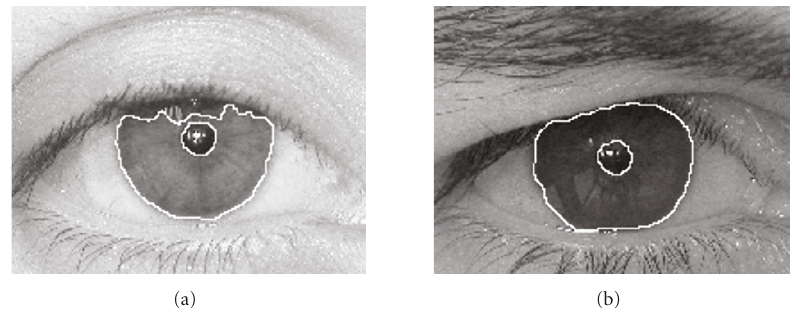
Figure 12: Localization of two samples from Ubiris database with proposed method.